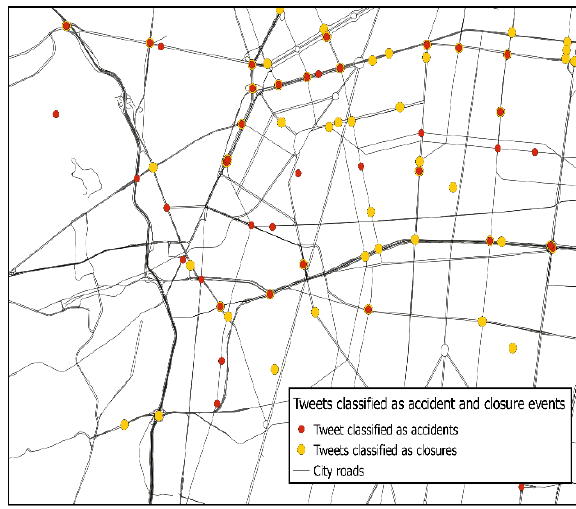
Figure 2. Tweets related to traffic events in the study area.